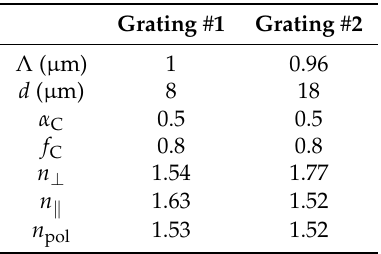
Table 1. Parameters of the gratings